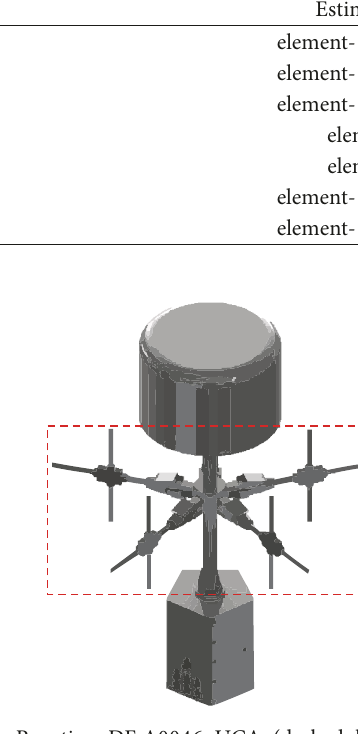
Figure 2: Poynting DF-A0046 UCA (dashed box) featuring 5 vertically polarised dipoles and 5 horizontally polarised monopoles. Only the dipoles will be considered in this